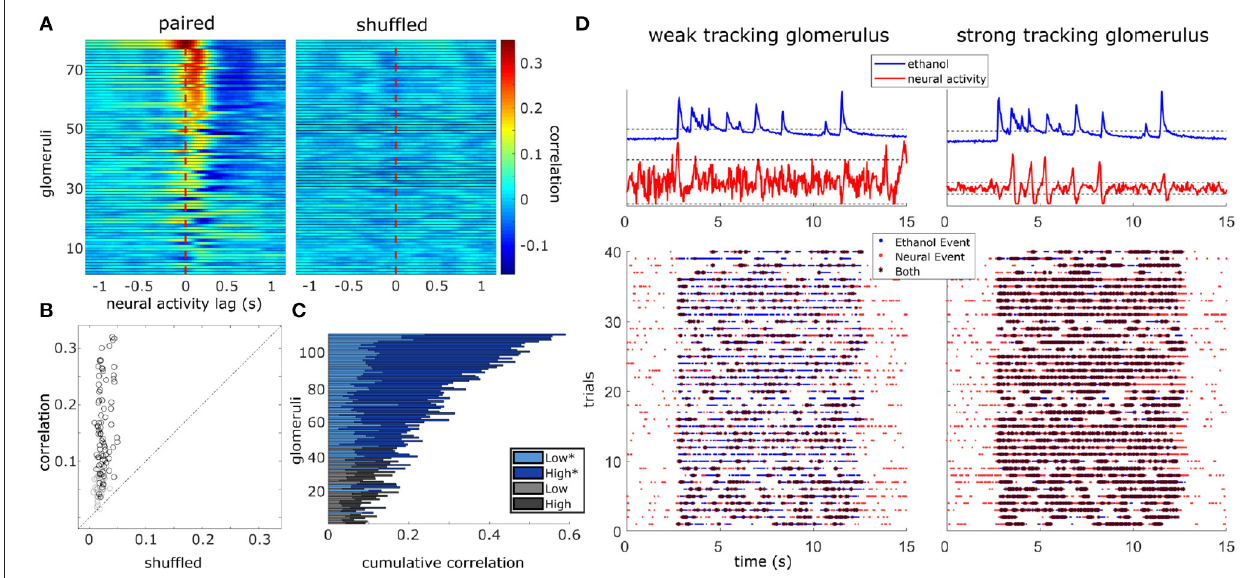
FIGURE 5 | Glomerular population activity follows odor concentration dynamics across plume encounters. (Left) The cross-correlation between the deconvolved ethanol trace and each glomerulus’s deconvolved activity trace is calculated within each trial and then averaged across trials. Each row is a glomeruli and each time point represents the cross-correlation at the indicated lag. Glomeruli are sorted in order of decreasing magnitude of correlation coefficient (see methods). (Right) Same as left but glomerular responses are trial shuffled so that the signals compared are not from the same trial. Glomeruli are sorted to match their corresponding unshuffled cross-correlation in the right panel. (B) Scatterplot of the correlation coefficient of all glomeruli if compared to their respective shuffled coefficient. Glomeruli plotted in (A) are marked in black if their coefficient exceeds their shuffled coefficient from a single trial shuffled comparison by 2 standard deviations. (C) The cumulative correlation, a sum of correlation coefficients for each glomerulus in low and high flow, are plotted as a stacked bar graph so that comparisons between mean responses can be made within and across glomeruli simultaneously. The cumulative plotting shows variation in ability to detect changes in odor concentration dynamics across glomeruli both within and across flow conditions. On average, a glomerulus’s tracking ability varies significantly between conditions [ t (110) = 12.81, p < 0.001], with most glomeruli having stronger correlation coefficients in high flow trials. Glomeruli that significantly correlate with plume dynamics in at least one condition are plotted in blues (*) while those that do not are plotted in grays. (D) Binary cross-correlation. Top: Simultaneously recorded signals shown for two example glomeruli responding to the same example trial’s odor plume. Odor and glomerular activity traces plotted with their respective thresholds (dotted, odor threshold: mean during plume presentation, neural threshold: ± 2 st. dev of baseline). Bottom: Resulting binarized traces plotted for each trial illustrate the magnitude of concurrent activity as events (stars) between the plume and the response of each glomerulus across the experimental